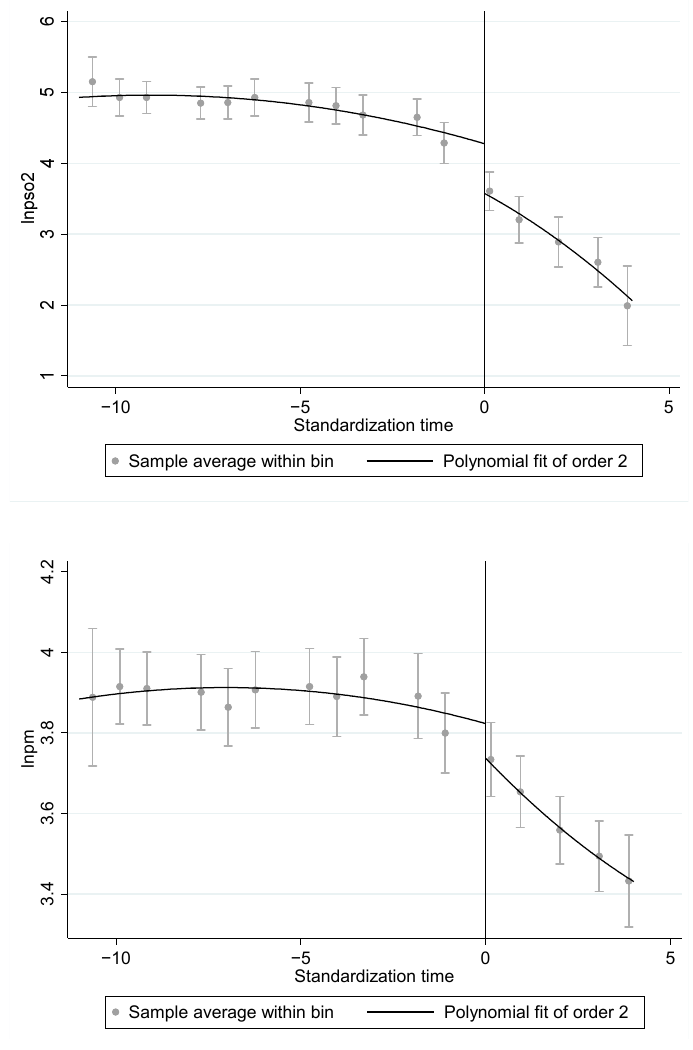
Figure 3. Breakpoint diagram.